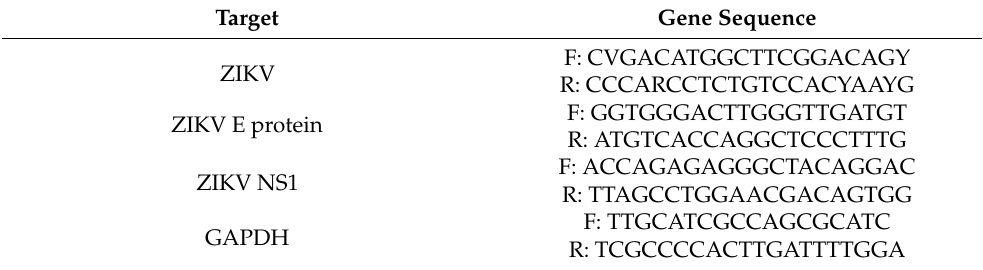
Table 1. Primer sequences for